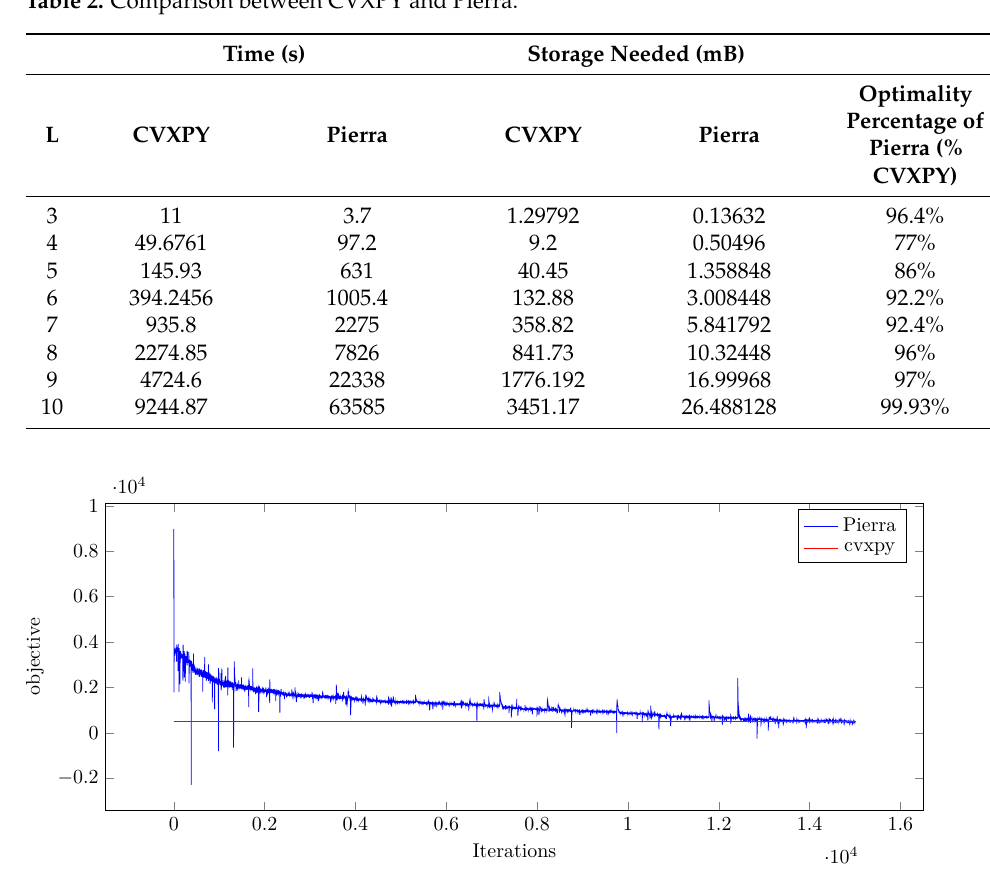
Table 2. Comparison between CVXPY and Pierra.